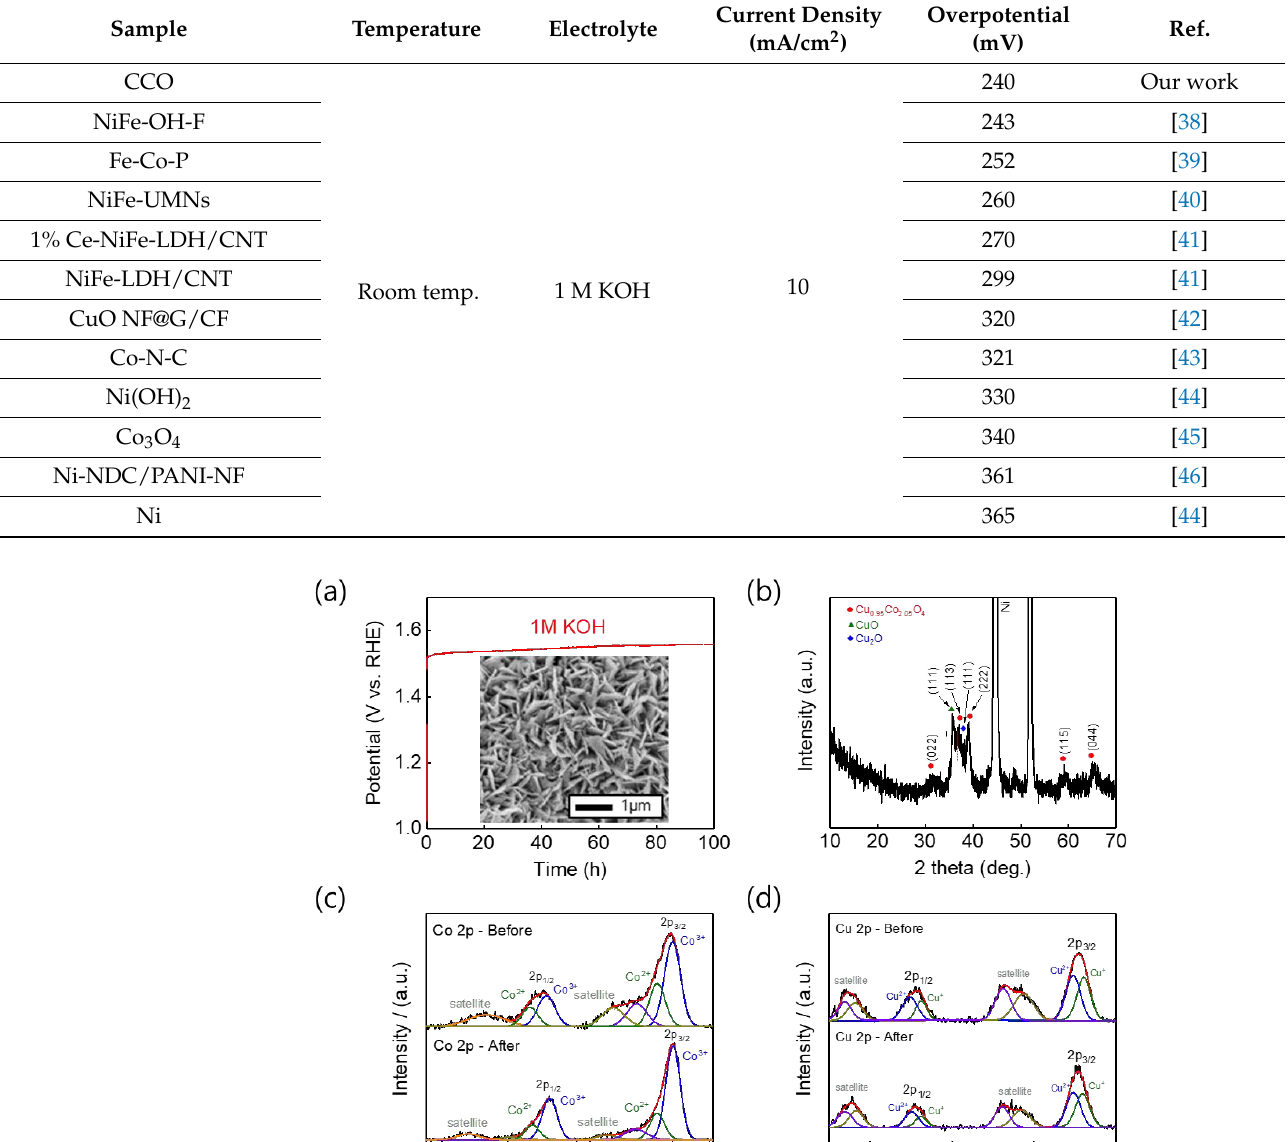
Table 1. Comparison of the reported OER activity.